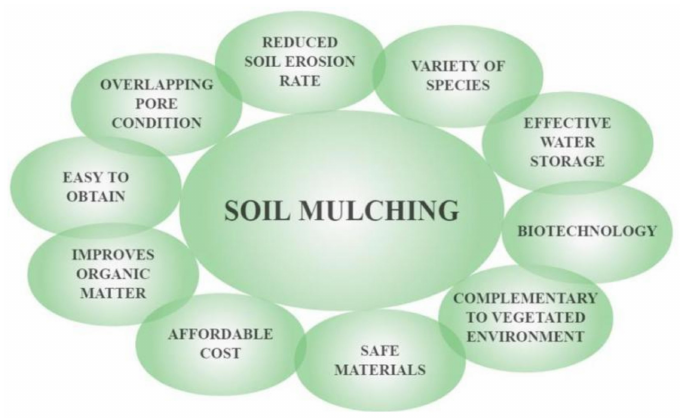
Figure 1. Properties and advantages of soil mulching in field operations. Its high competitiveness is a combination of multiple